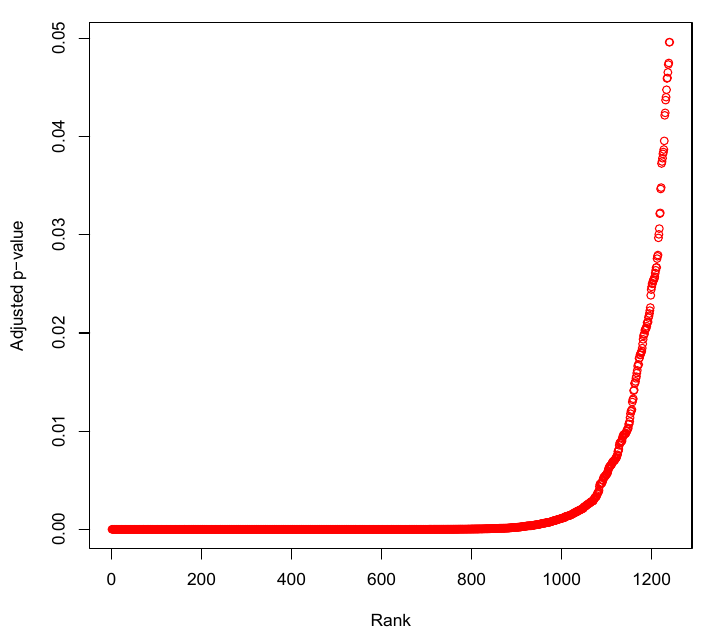
Figure 4. Plot of rankwise Bonferroni adjusted p -values for the differentially expressed genes.